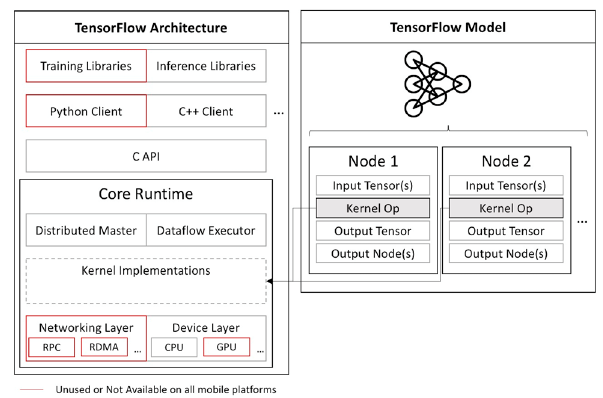
Figure 1. Overview of a TensorFlow Library built with Selective